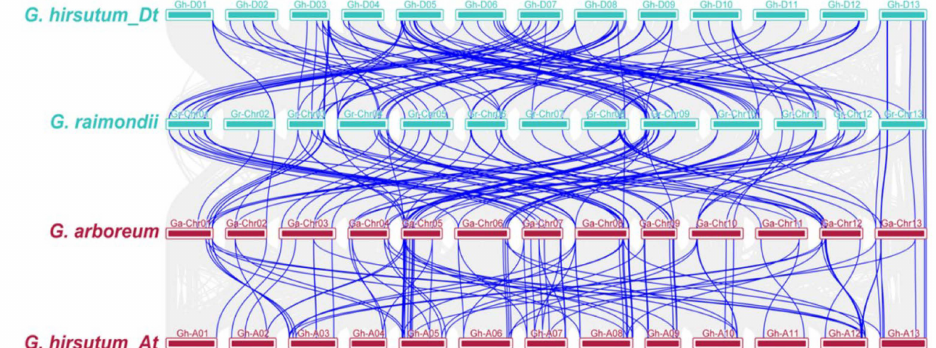
Figure 4. Synteny and collinearity relationships among G. arboreum (AA), G. hirsutum (At and Dt sub-genomes), and G. raimondii (DD). Blue and gray lines indicate NPF homologous gene pairs and collinear genes in the whole genome,